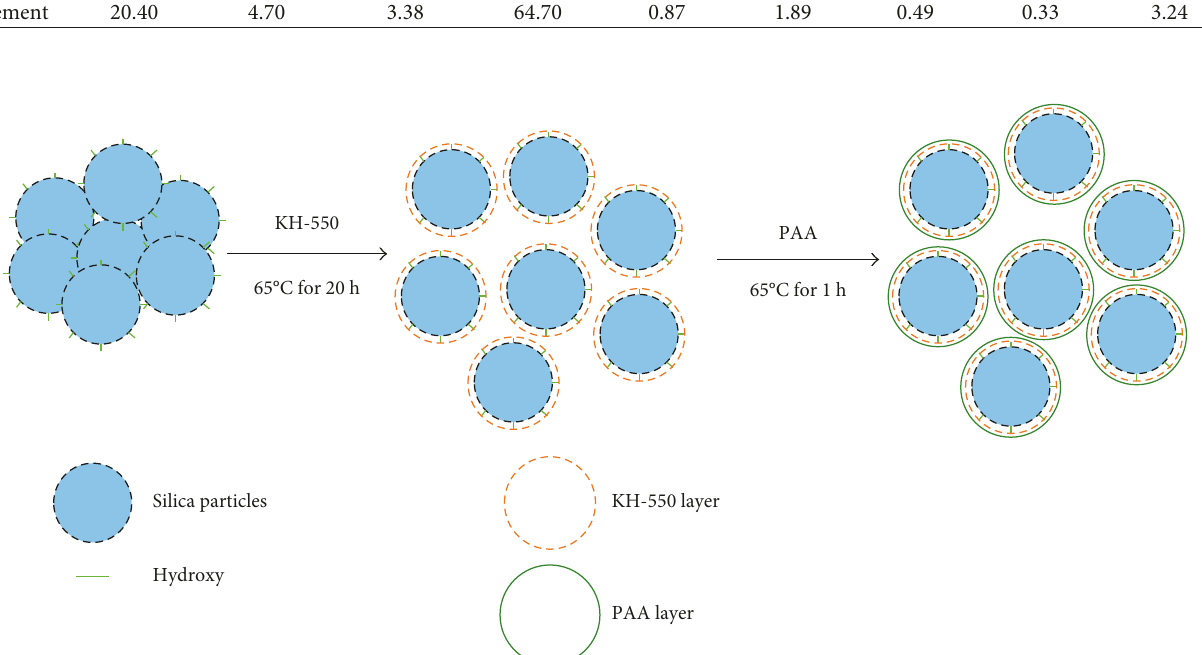
Figure 2: The brief schematic diagram of surface modification procedure.